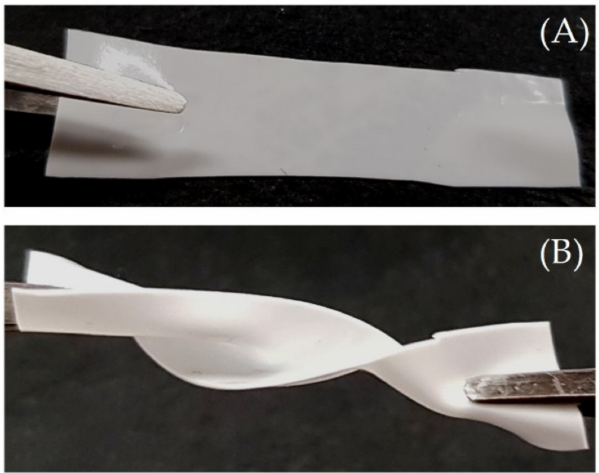
Figure 1. ( A ) Obtained and ( B ) twisted ionogel poly(TATT+TMPTP) with 70 wt.% of